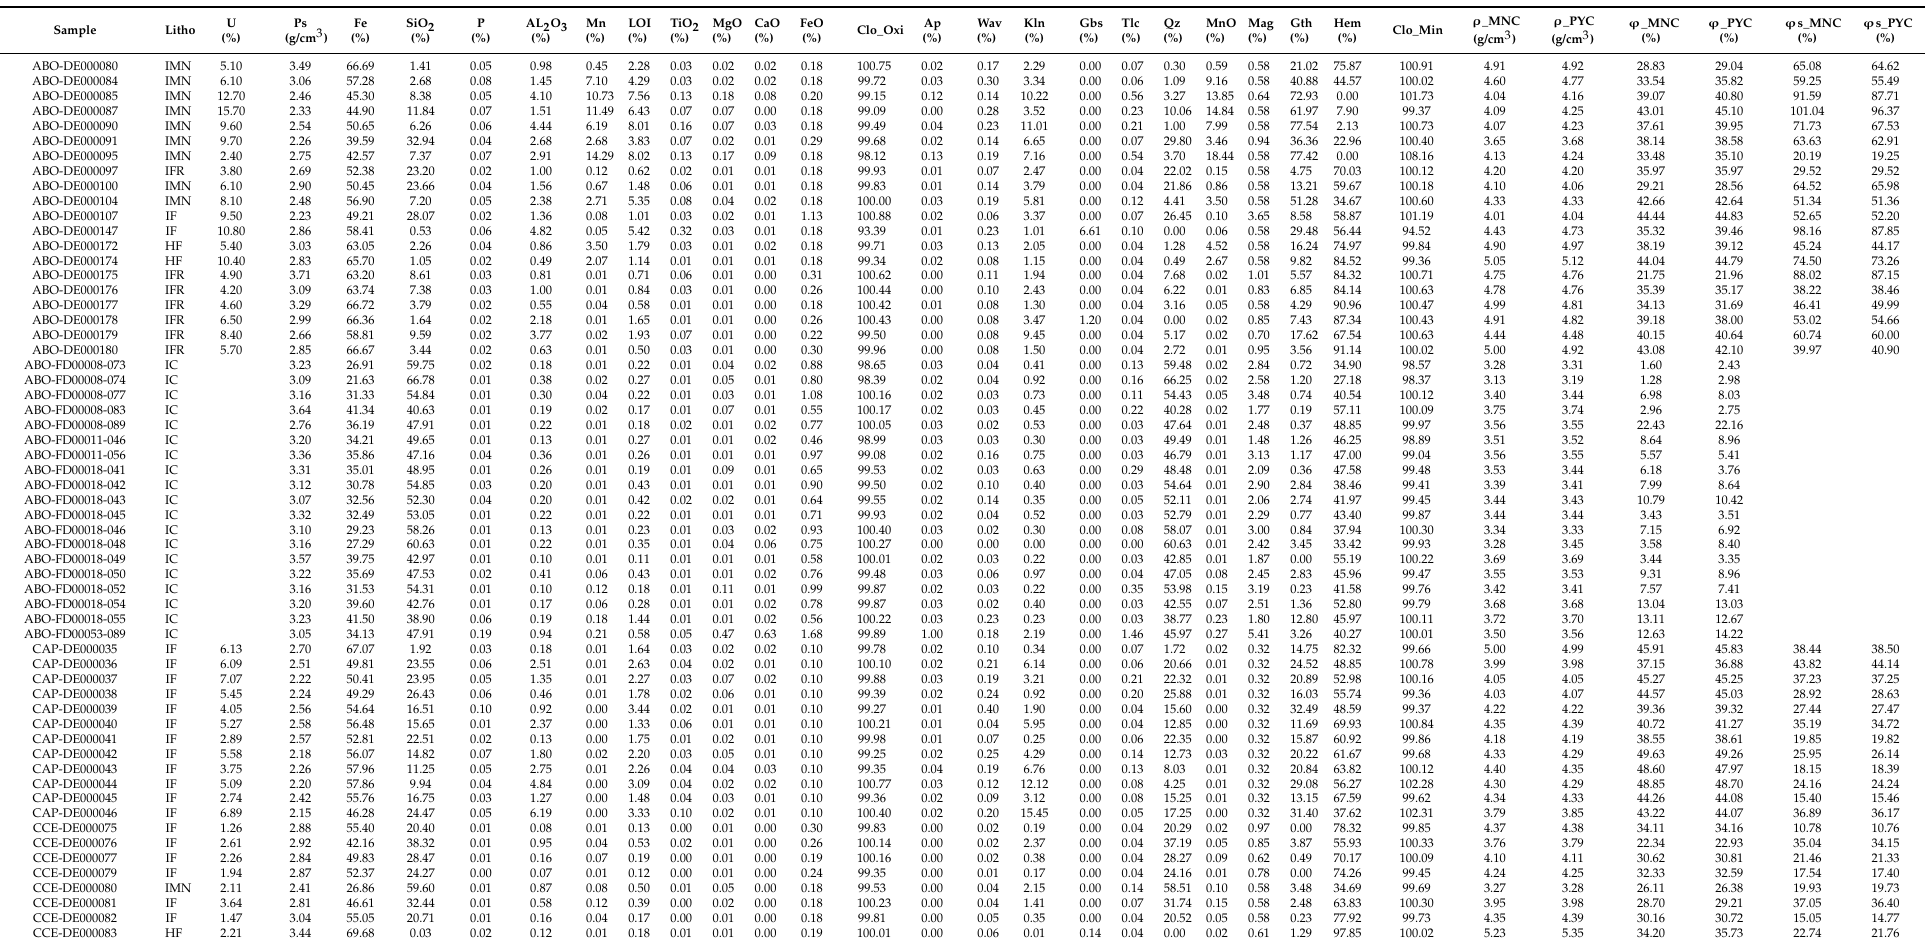
Table A1. Original weathered sample data with lithology, chemical grades, bulk density, moisture, and mineral density (PYC) measurements and calculated mineral proportions, mineral density (CNM), porosity (CNM and PYC), and saturation (CNM and